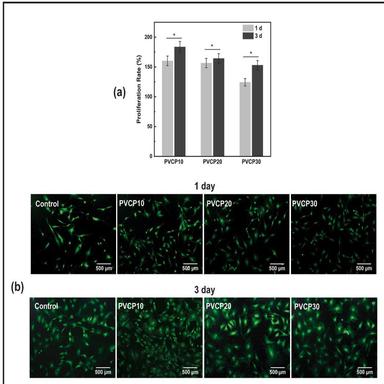
The in vitro biocompatibility study of CPS-PVDF extract culture medium with osteoblast cells. (a) The osteoblast cell viability was detected by CCK-8 assays. Osteoblast cells were cultured in the respective extract culture medium for 1 and 3 d. The relative proliferation rate was calculated as viabilityCPS-PVDF/viabilitycontrol. There were eight technical replicates in each group (n = 8), and one error bar represents one standard deviation. represents the significant level at p < 0.05. (b) The Live/Dead st